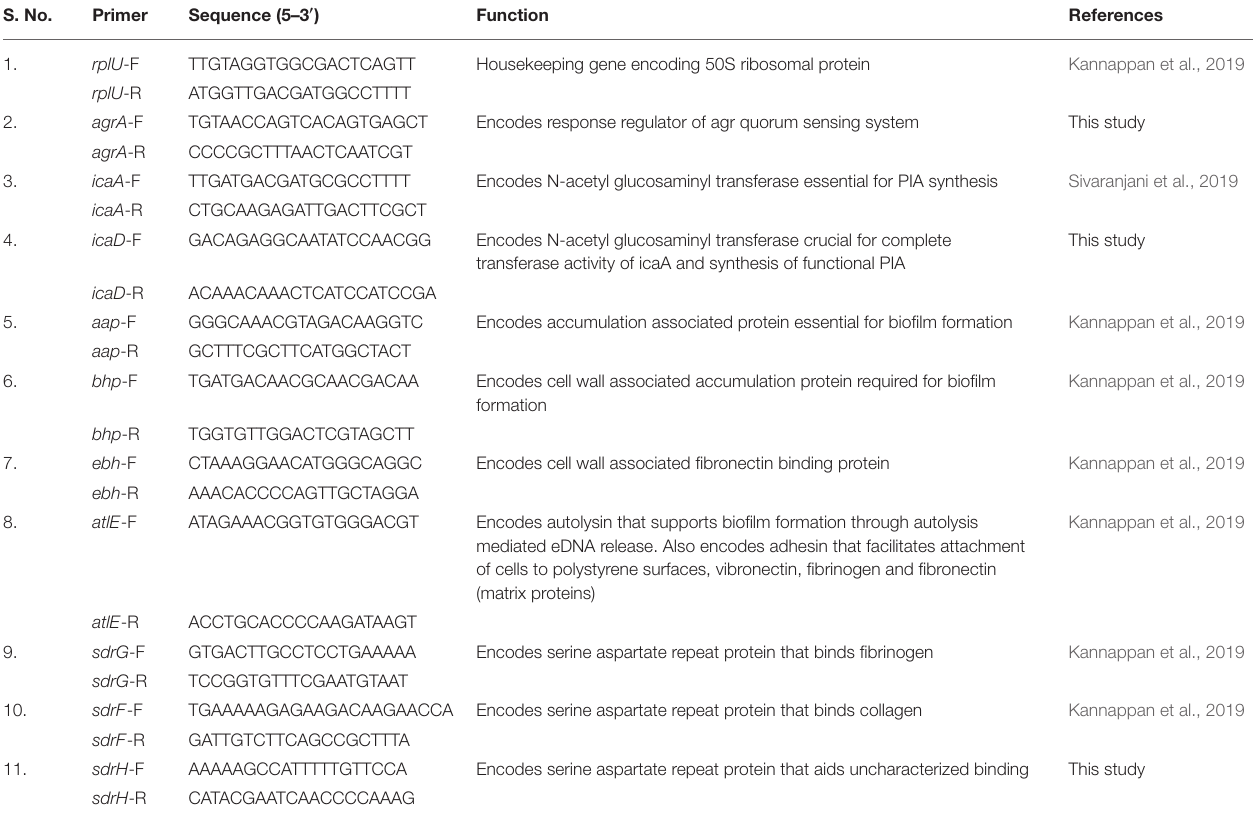
TABLE 1 | Primer sequences and function of candidate genes used in the study. S.